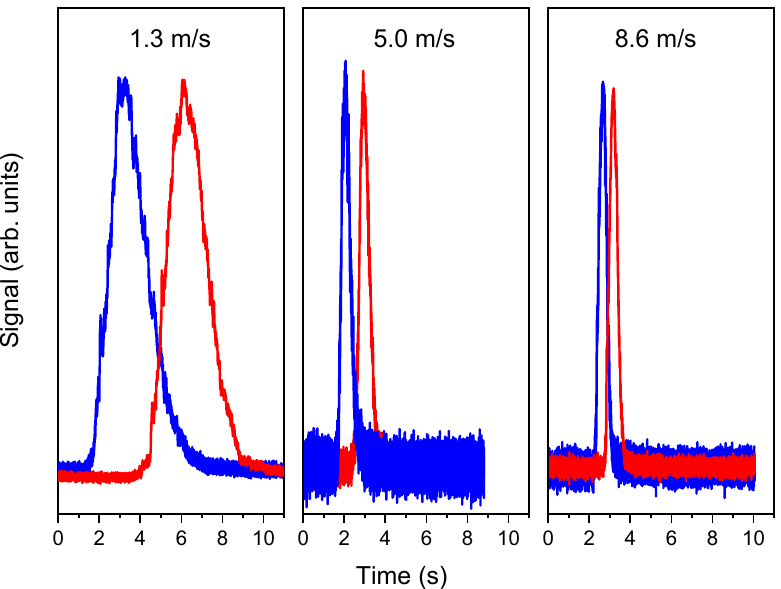
Figure 9. Set of Transit Time (TT) measurements at three different flow speeds, at the lower (blue) and upper (red) measurement